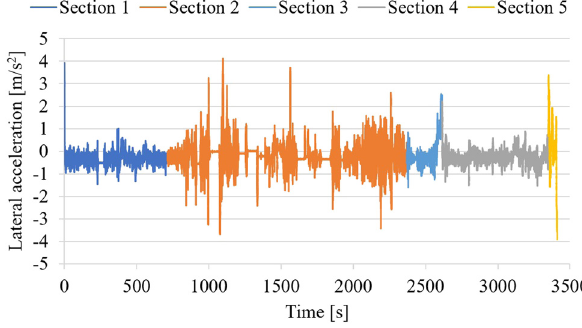
Figure 10: Lateral accelerations – afternoon drive.